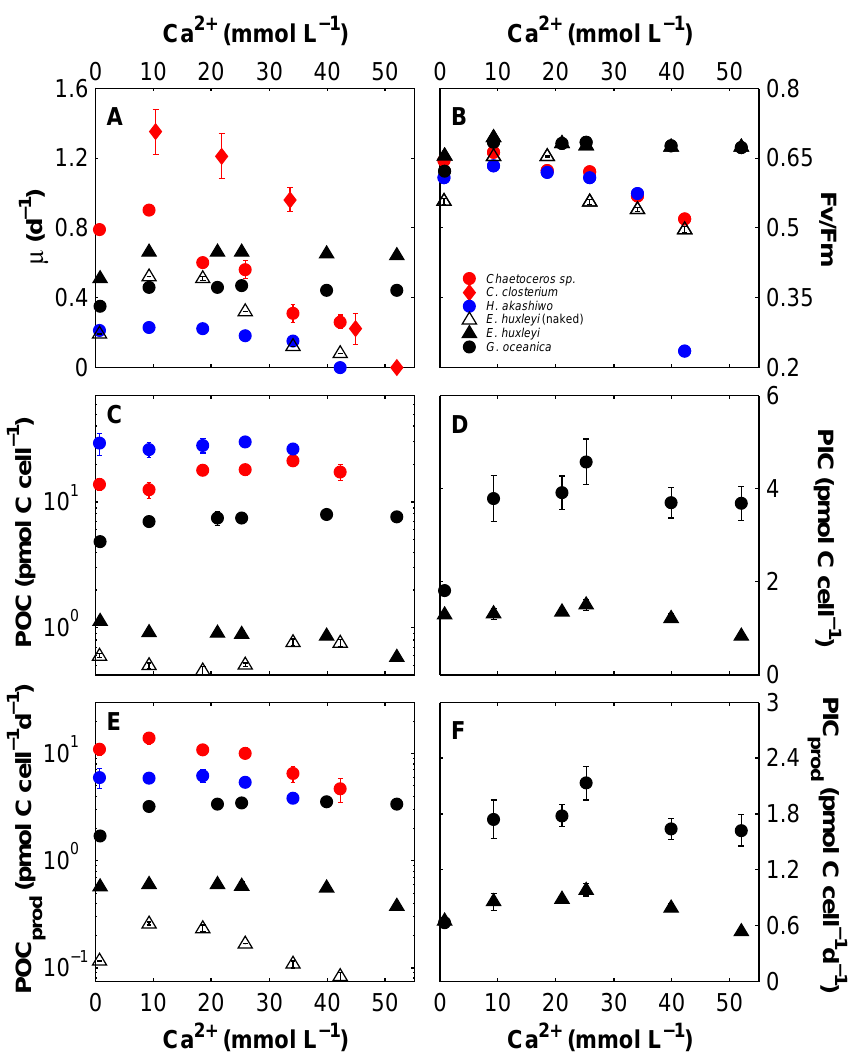
Figure 2. Phytoplankton physiological responses to seawater Ca 2 + concentration. Displayed are laboratory-cultured strains of diatoms (red markers), raphidophytes (blue markers), coccolithophores (black markers) and a non-calcifying coccolithophore (black open marker): (a) species-specific growth rate, (b) maximum quantum yield of photosynthesis (Fv/Fm), (c) cellular POC and (d) PIC quotas, (e) cellular POC and (f) PIC production rates as a function of seawater Ca 2 + concentration. Error bars denote ± 1SD ( n = 3). Note that the physiological response of Ceratoneis closterium was only determined via growth rate measurements. POC quota of H. akashiwo could not be determined at a Ca 2 + concentration of 42mmolL − 1 due to lack of